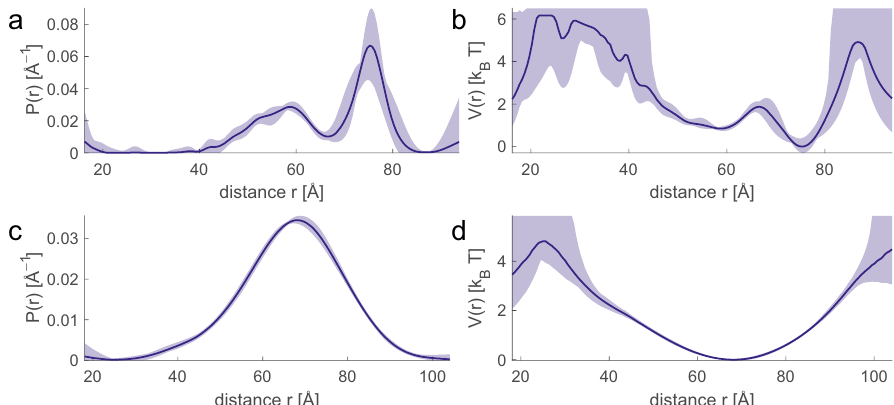
Figure 3. Equivalence between distance distributions ( a , c ) and potentials of mean force ( b , d ) for protein site pairs 71/475 ( a , b ) and 235/475 ( c , d ) in the complex of polypyrimidine tract binding protein 1 with encephalomyocarditis virus internal ribosome entry site. Data from